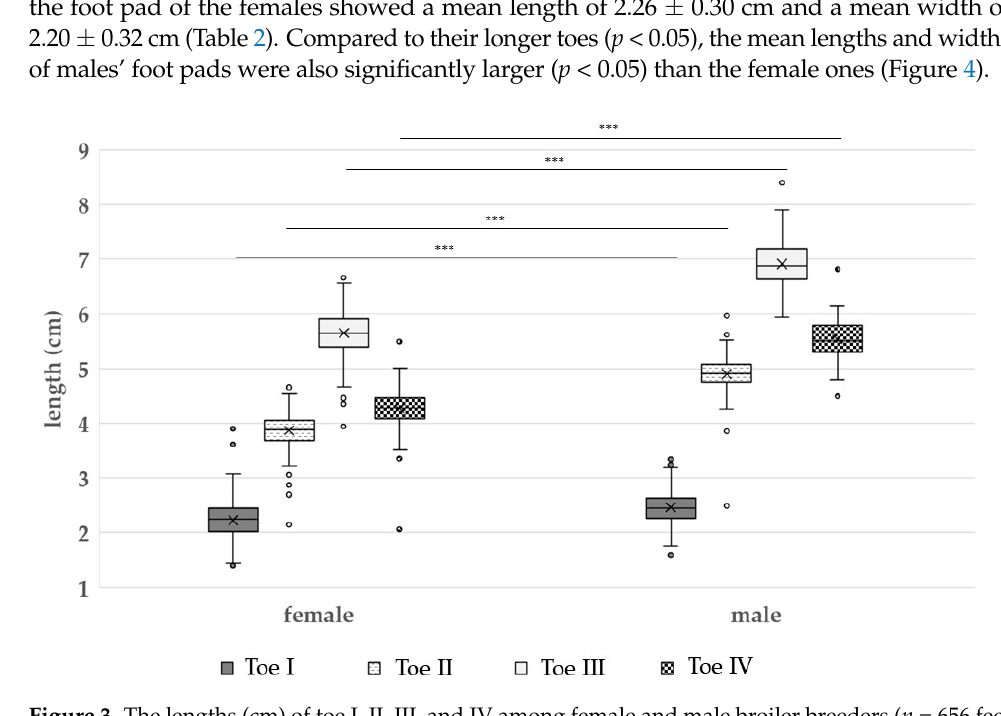
Table 2. Measurements (cm) at time of slaughter of toe I–IV and foot pads of female ( n = 506 feet) and male ( n = 150 feet) broiler breeders, as well as length and width and the foot length in total (toe I + foot pad length + toe III).